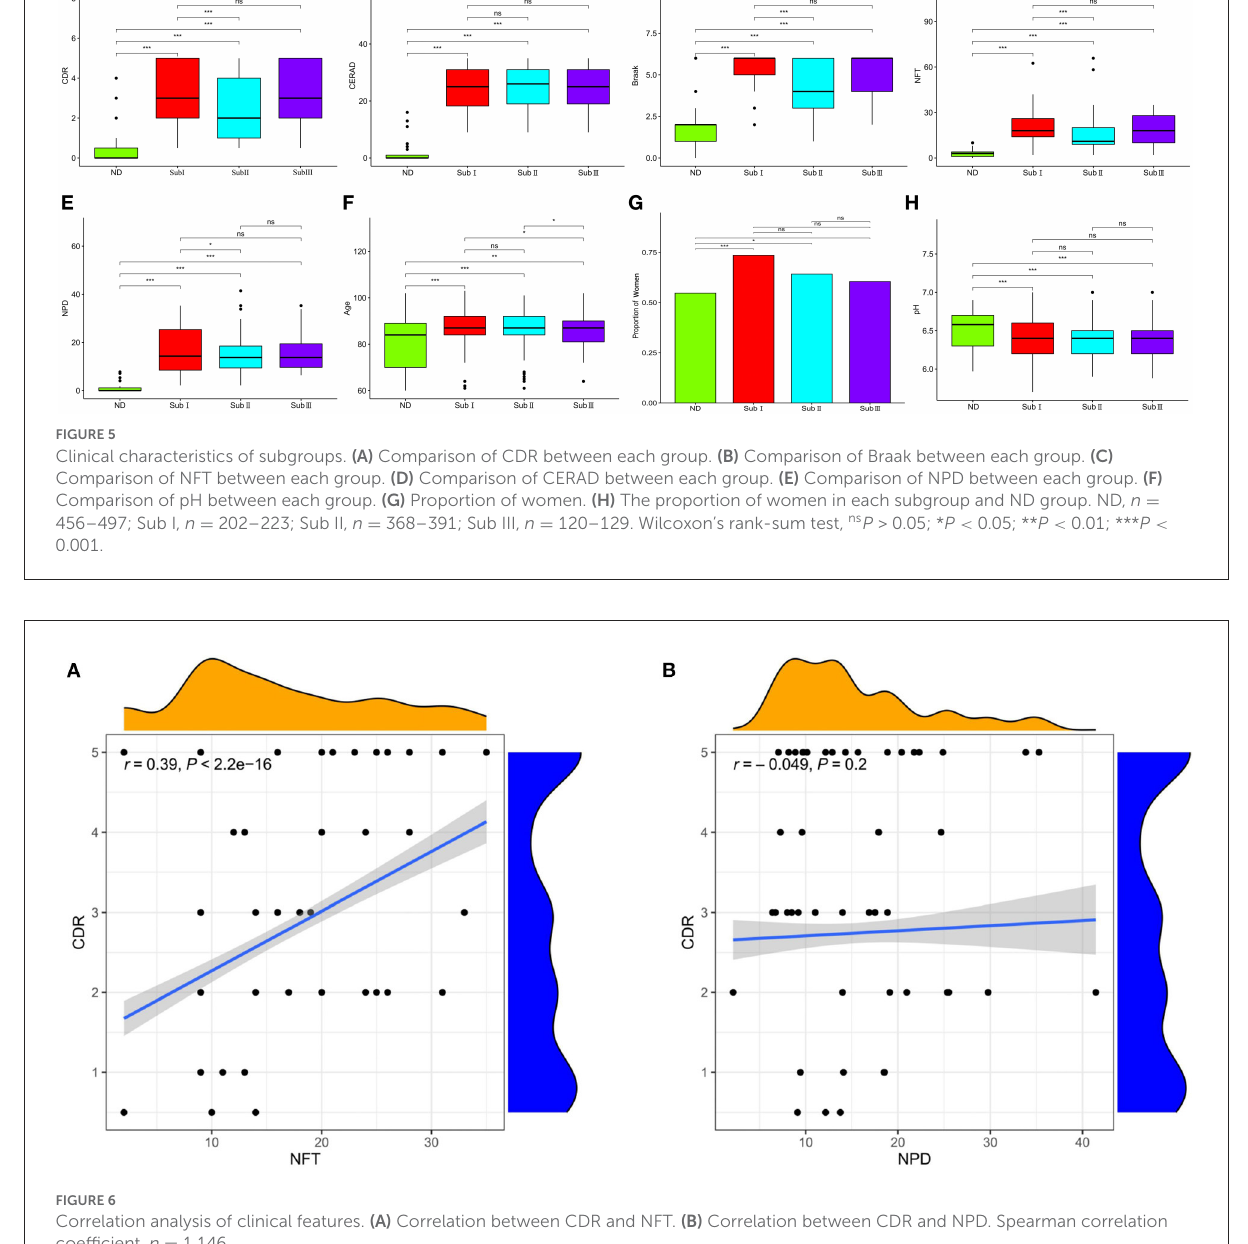
in previous studies that merely compare normal and